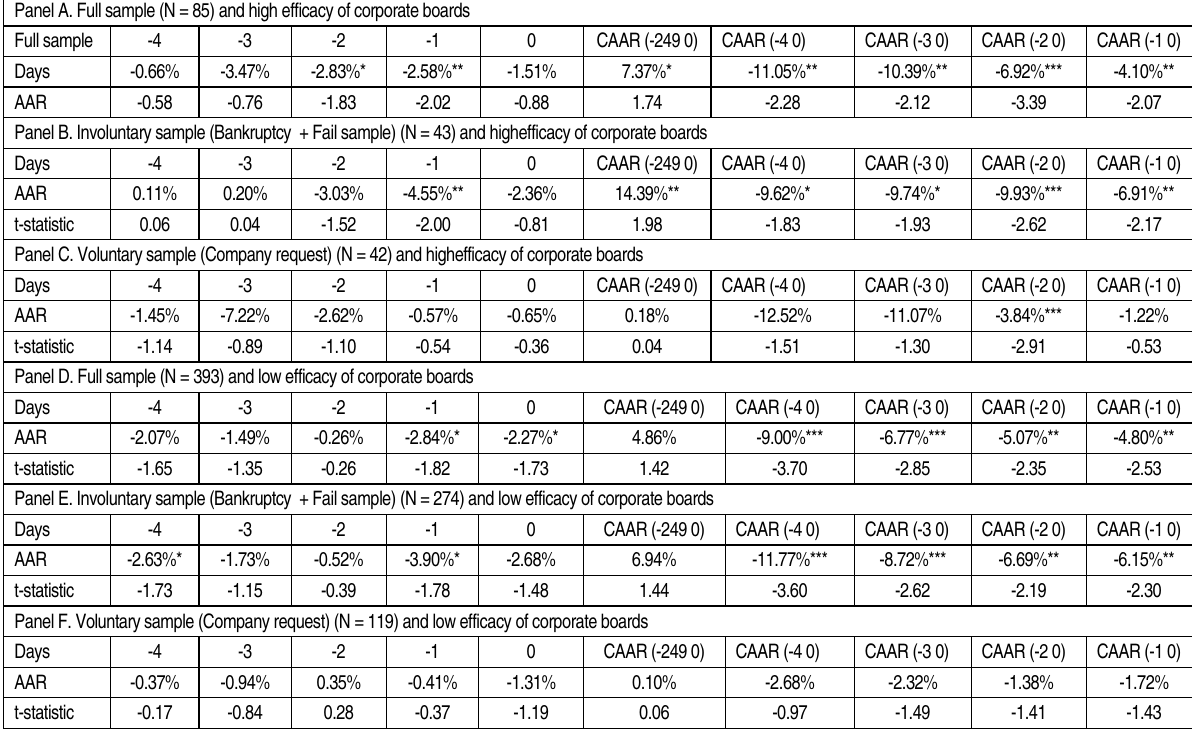
Table 4. Average abnormal returns and cumulative average abnormal returns around delistings announcement days based on the degree of efficacy of corporate